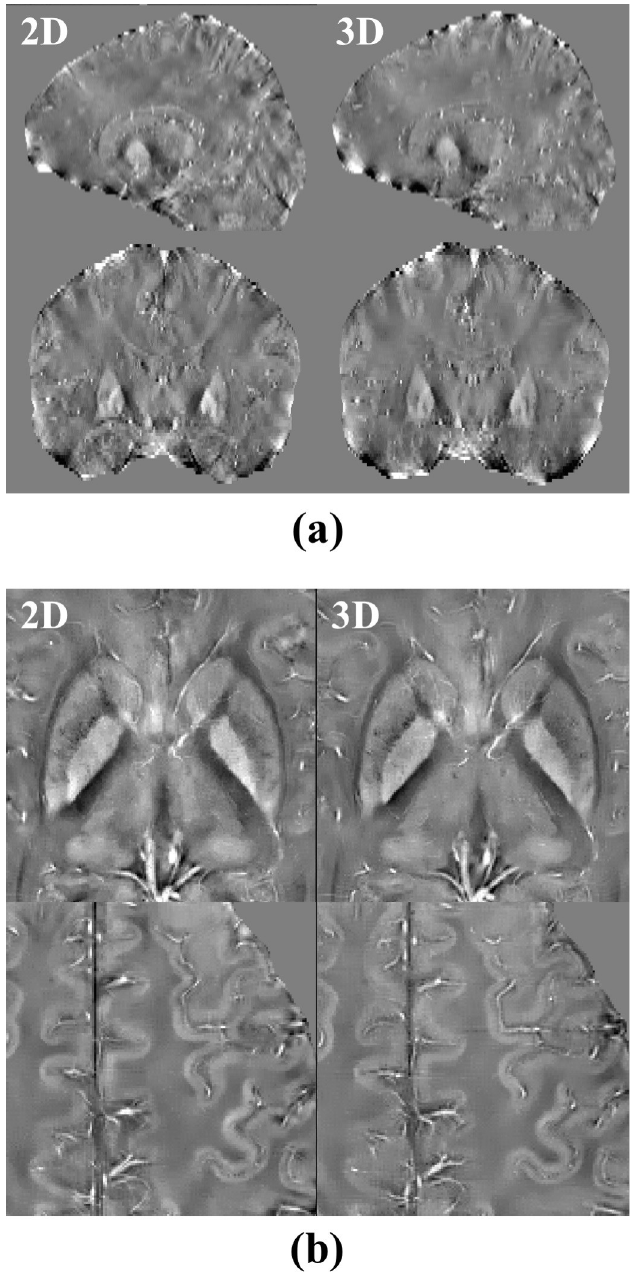
Fig 4. QSM images from a volunteer acquired using the 2D SMS gradient-echo ( left column ) and 3D gradient- echo ( right column ) sequences. (a) Neither the sagittal nor coronal images show streaking artifacts on either 2D or 3D images. (b) The 2D image shows a better contrast between globus pallidus and putamen than the 3D image ( top row ). Other deep gray matter ( top row ) and cortical gray/white matter ( bottom row ) show equal contrast on both the 2D and 3D